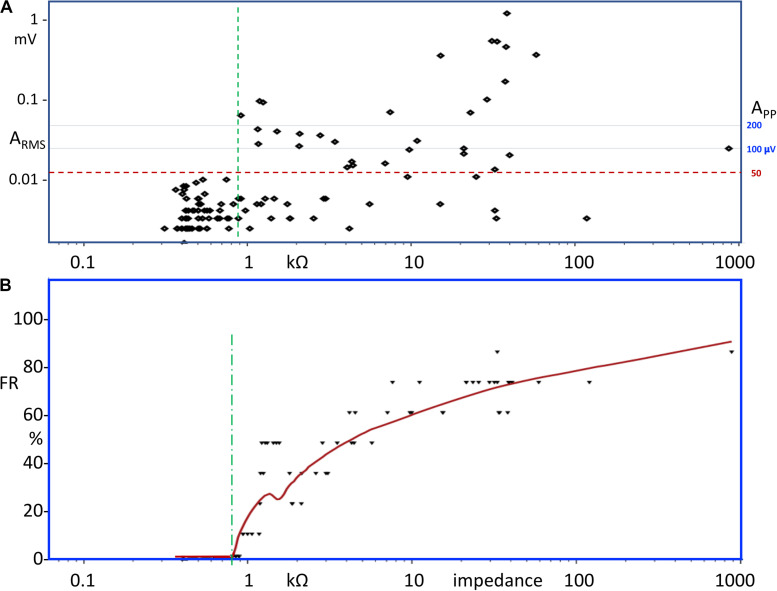
(A) Scatter plot of RMS MEP amplitudes as a function of the electrode impedance (N = 114 points). (B) Running average of the failure rate (FR) over a frame width of eight subsequent impedance values. The FR values are plotted at the end of the frames. FR is computed as the percentage of MEP amplitudes within the frame above ARMS = 12 μV, which agrees with about APP = 50 μV (horizontal dashed line). The vertical dashed lines denote the impedance borders below which in panel a no background noise amplitudes exceed ARMS = 12 μV and in (B) FR = 0. (B) LOESS local regression curve of the FR as function of electrode impedance. A vertical dashed line indicates the impedance value at which the FR becomes greater than zero.